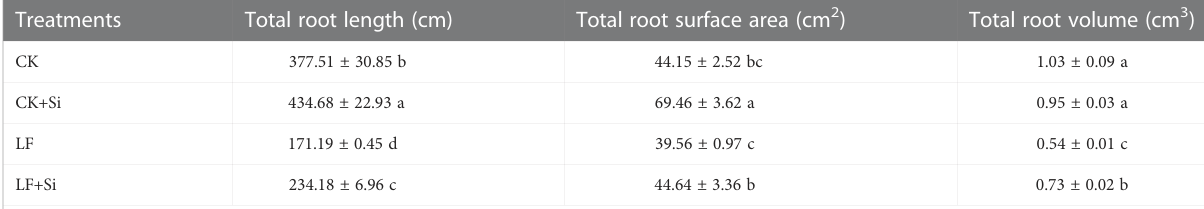
TABLE 1 Silicon improved different root features in tomato seedlings under Fe de fi ciency.